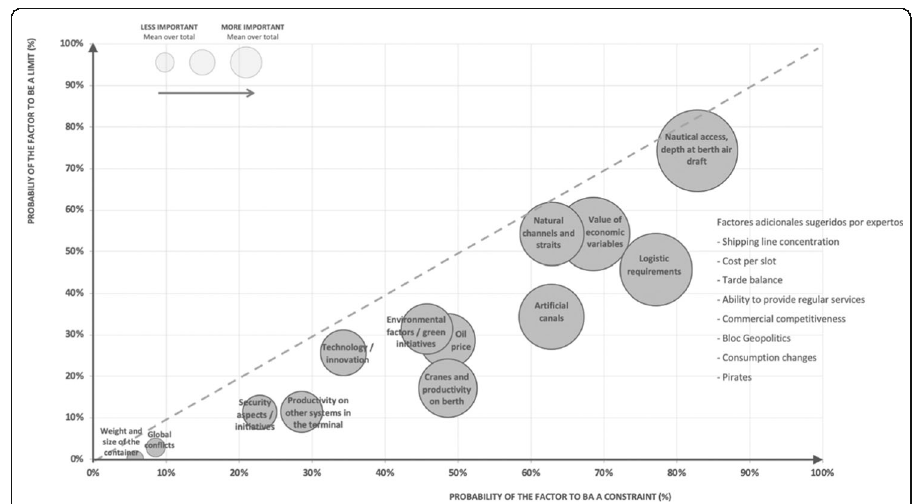
Fig. 6 “ Experts ’ group vision ” of the factors that will constrain the growth trend of large containerships in the next 20 years, given in 2011. Source: (Gomez Paz et al. 2015). Updated with additional factors pointed out by the experts in